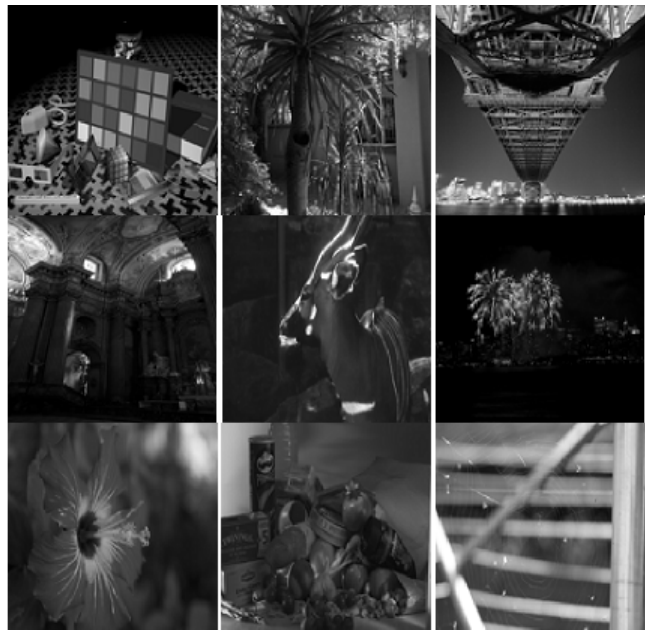
Figure 14. Examples of 8-bit greyscale images.